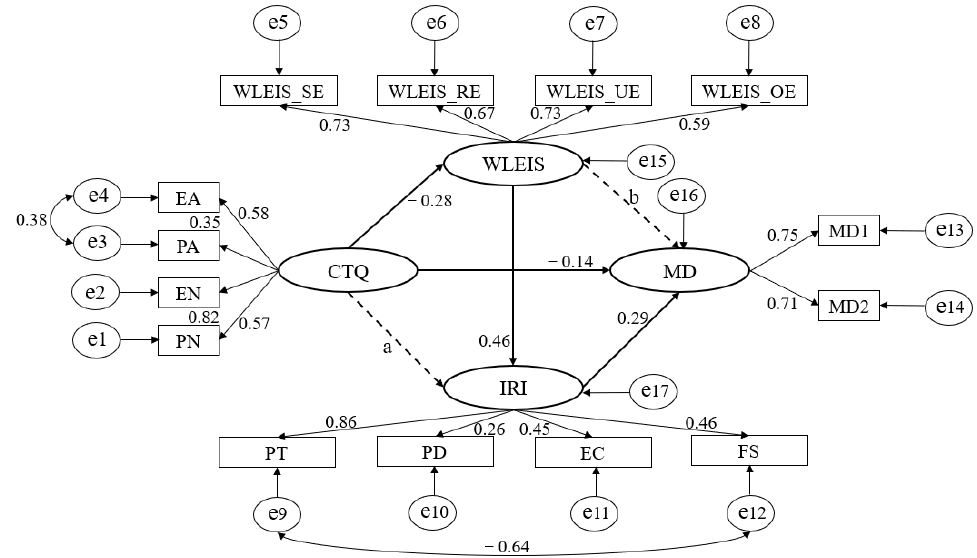
Figure 1. The standardized mediation model.